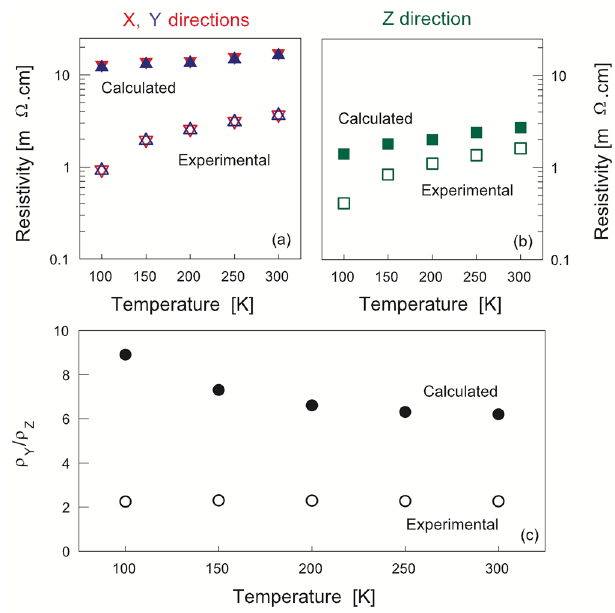
Figure 6. ( a , b ) Comparison of experimental resistivity values (open symbols) with values calculated by averaging over crystallite orientations (full symbols) using the orientation distribution refined from the measured pole figures with the extended-Williams-Imhof-Matthies-Vinel (E-WIMV) iterative algorithm; ( c ) Calculated (full symbols) and experimental (open symbols) resistivity ratios.